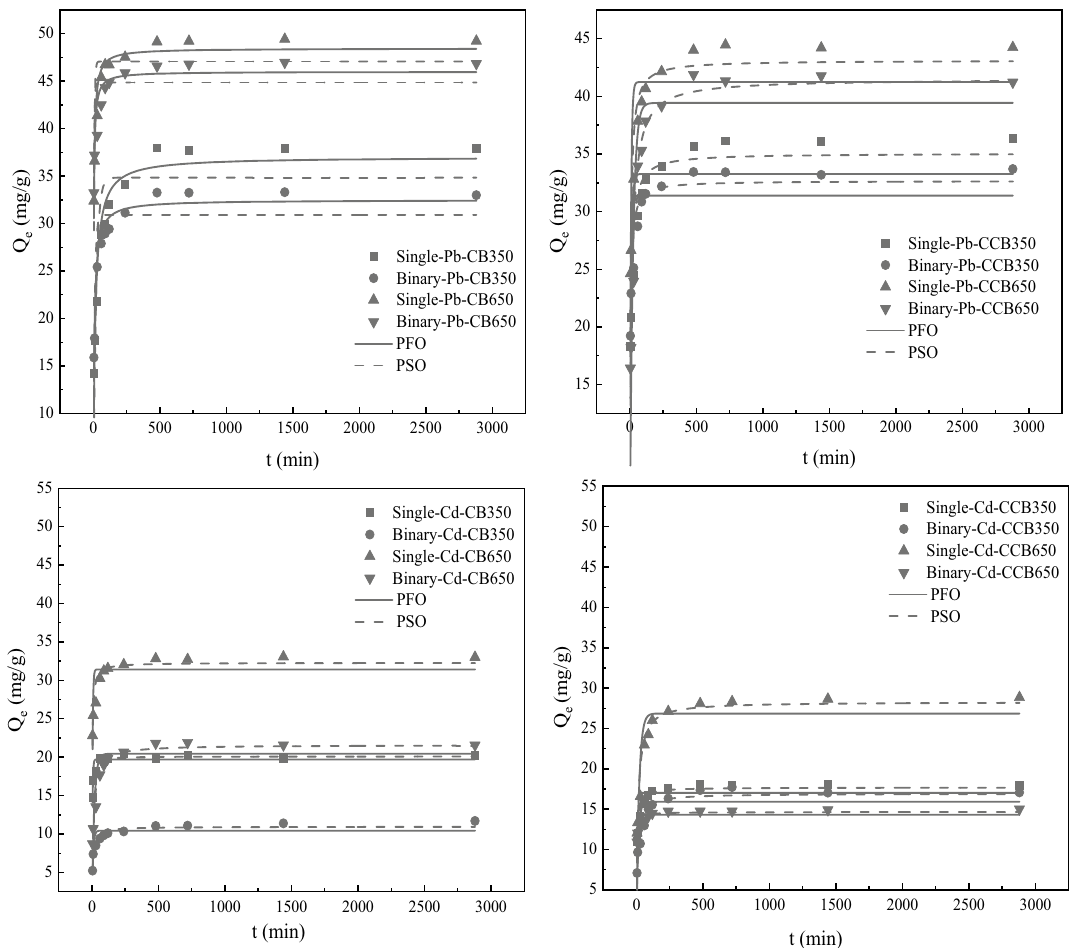
Figure 2. Adsorption kinetics of Pb 2+ and Cd 2+ on the fresh and aged biochars in the single and binary